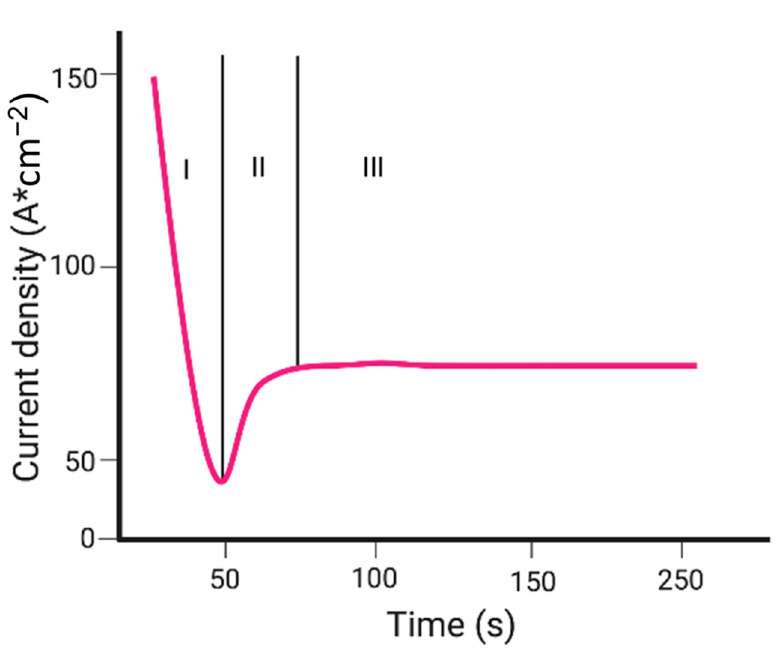
Figure 4. Representative current–time curve for the formation of TiO 2 by anodization using F − electrolytes under a constant voltage. The curve is divided into 3 phases. Phase I is characterized by a noticeable current decay. Phase II raises the current under a time lag, and phase III reaches a constant steady current.